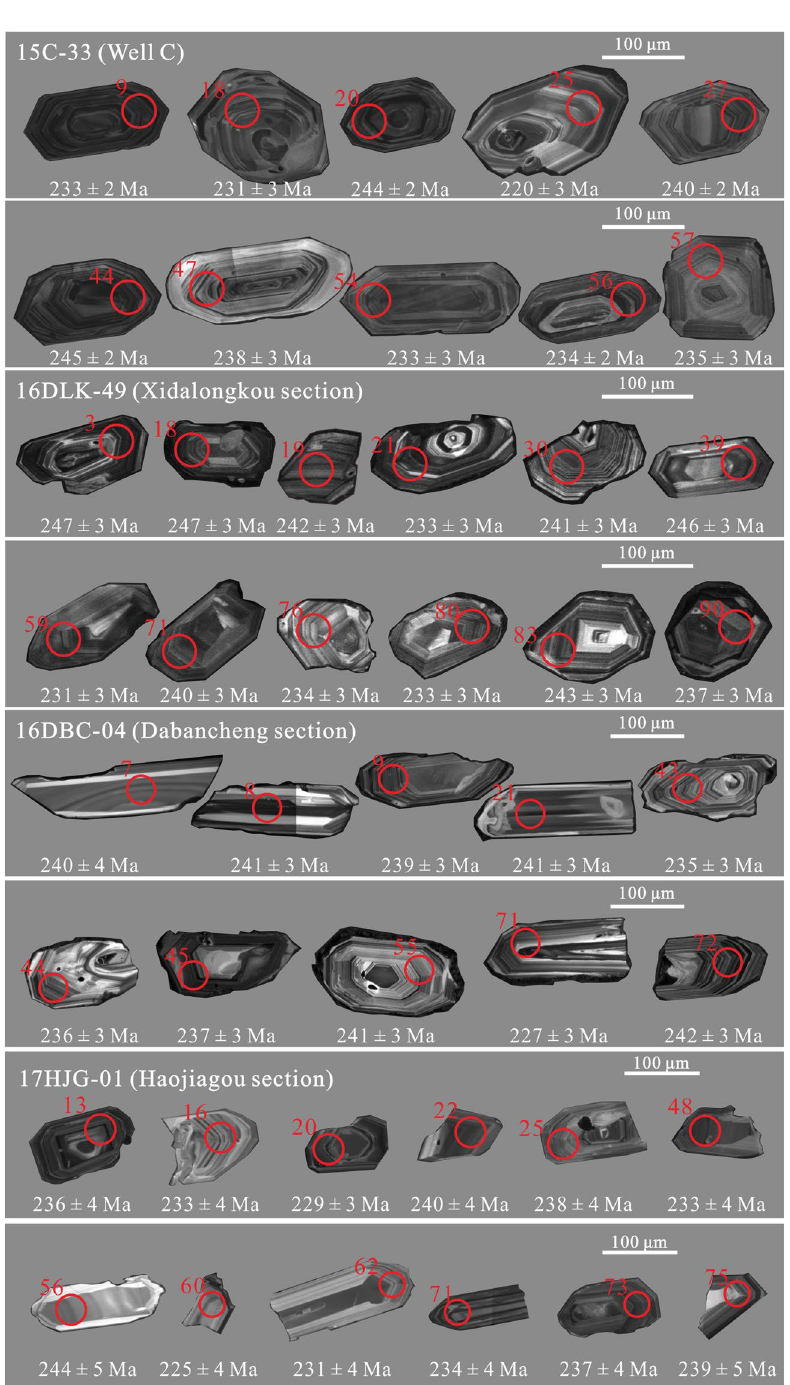
Figure 7. Representative cathodoluminescence (CL) images of the Triassic zircon